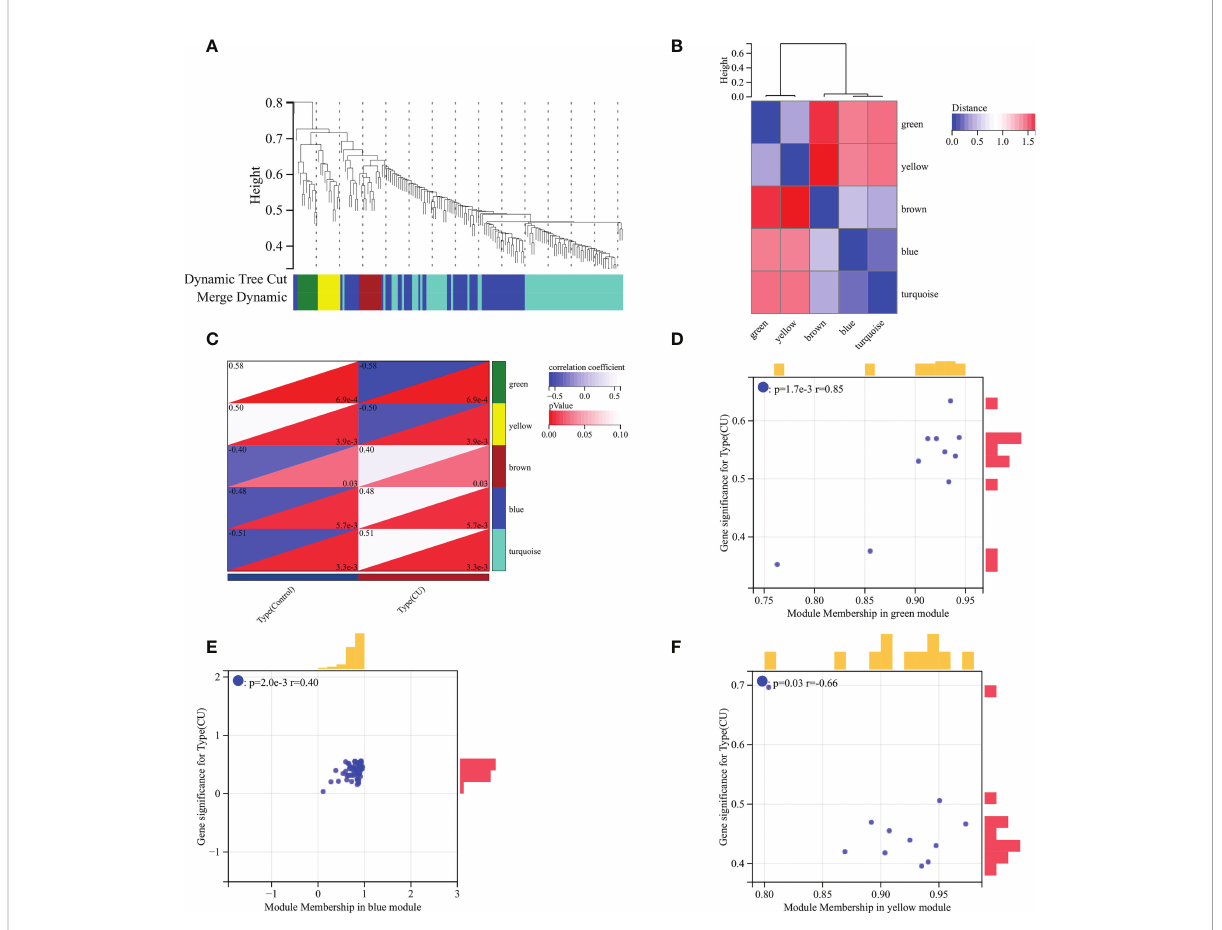
FIGURE 4 WGCNA analysis. (A) Gene clustering dendrogram. (B) Heatmap of the association among modules. (C) Module-trait relationships heatmap. (D) Correlation chart between gene members of the green module and gene signi fi cance. (E) Correlation chart between gene members of the blue module and gene signi fi cance. (F) Correlation chart between gene members of the yellow module and gene signi fi